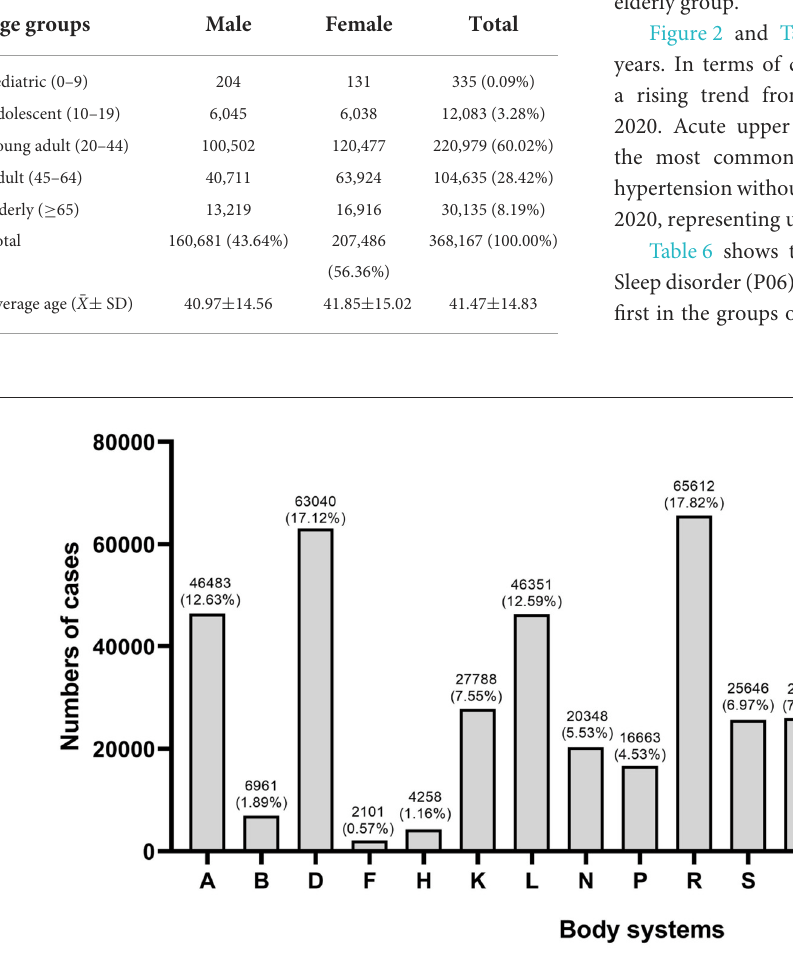
TABLE 1 Demographic characteristics of participating parents.